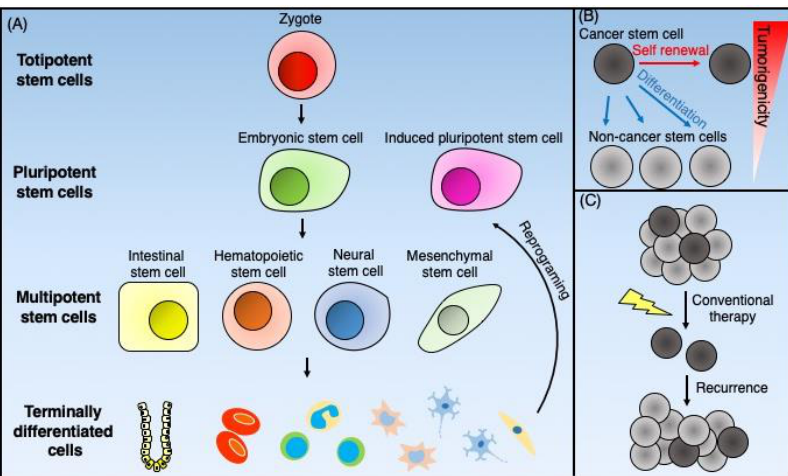
Figure 2. Schematic representation of the normal stem cells and cancer stem cells. ( A ) Totipotent stem cells, such as zygotes, can generate all the types of cells that form total individual organisms. Pluripotent stem cells can give rise to all three germ cell layers. The inner cell mass of blastocysts furnishes embryonic stem cells, and the reprogramming of terminally di ff erentiated cells supplies pluripotent stem cells. Multipotent stem cells can di ff erentiate into organ-specific cell lineages. Adult tissue-specific stem cells such as intestinal stem cells, hematopoietic stem cells, neural stem cells, and mesenchymal stem cells give rise to terminally di ff erentiated cells to maintain tissue homeostasis. ( B ) Cancer stem cells (CSCs) are cancer cells that possess stem cell-like properties. CSCs have both self-renewal ability and di ff erentiation potential into non-CSCs, which have low tumorigenicity. ( C ) CSCs have resistance against conventional chemotherapy and radiotherapy because of multiple mechanisms. As a result of this resistance, CSCs survive such treatments and cause tumor